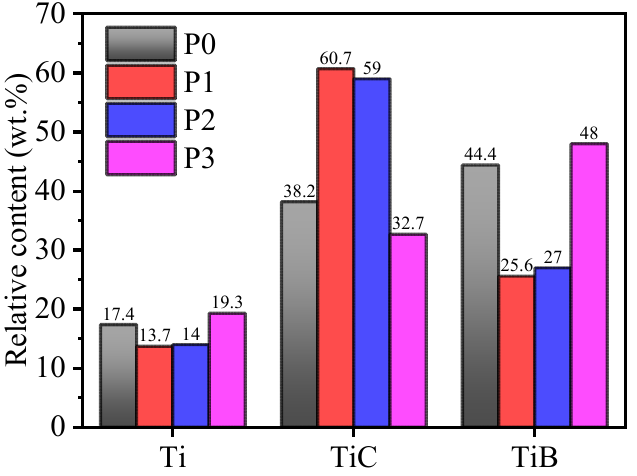
Figure 6. Relative contents of Ti, TiC and TiB phases in coatings fabricated with different ultrasonic power.